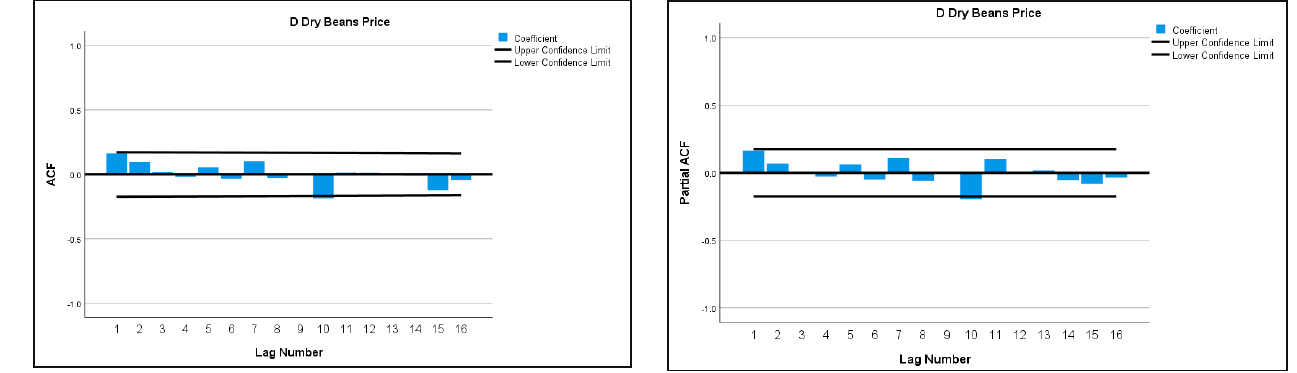
Figure 2. ACF and PACF Correlograms of Differenced Dry Cocoa price series. Source: Authors processing using SPSS package.